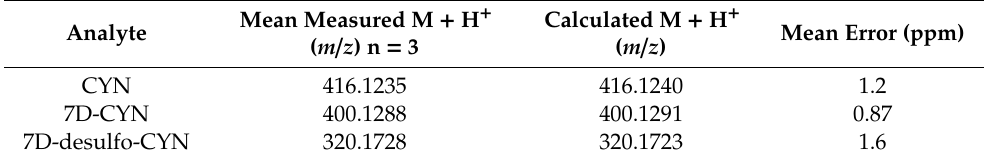
Table 1. Mean measured and calculated monoisotopic m / z value (including the mean error) of the protonated precursor ion (M + H + ) of each of the isolated cylindrospermopsins. All measures were performed on a QTOF mass